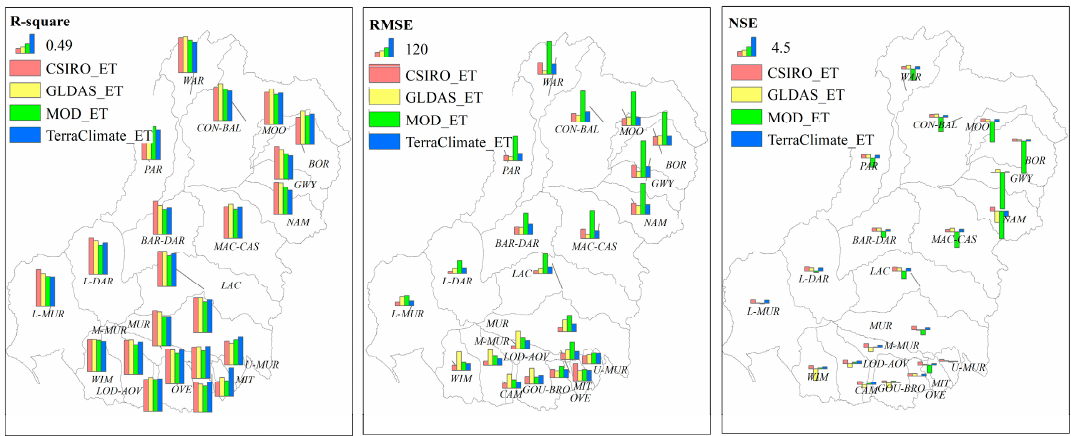
Figure 6. Bar plots showing the statistics ( R 2 , RMSE and NSE ) of annual ET estimated with CSIRO ET , GLDAS ET , MOD ET and TerraClimate ET products within the 22 catchments of the Murray Darling Basin when compared with the annual AWAP ET levels. The embedded bar plots with numbers at the upper-left corners are the scales for interpreting the bars associated with each